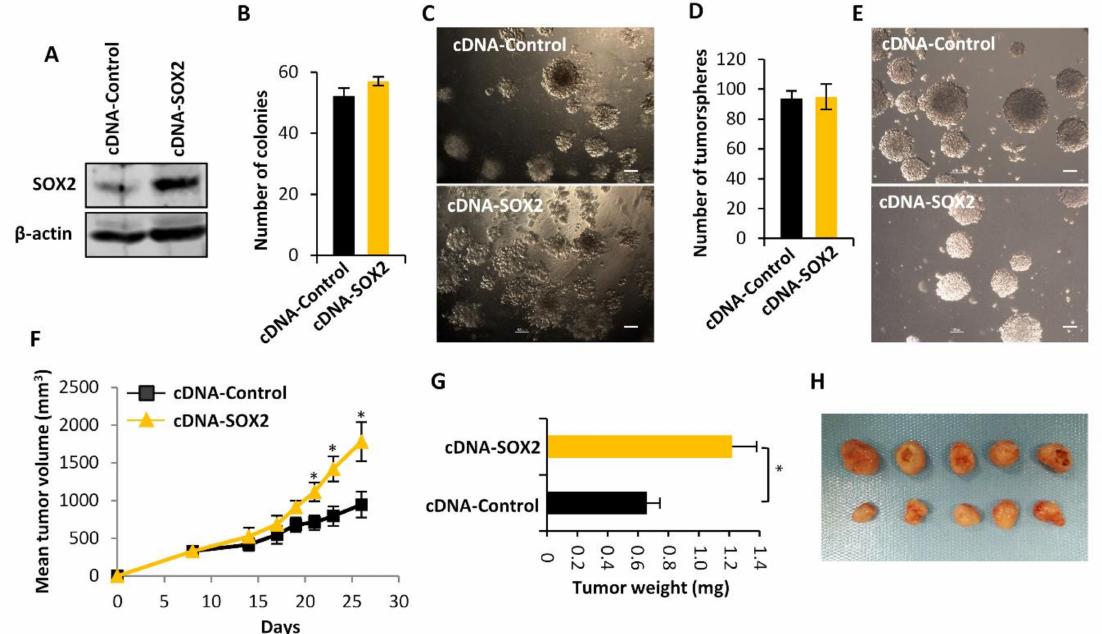
Figure 3. The overexpression of SOX2 increased the tumorigenic potential of sarcoma cells. T-5H-0 cells were stably transduced using lentiviral vector to express EGFP cDNA (cDNA Control) or human SOX2 cDNA (cDNA SOX2) sequences. ( A ) Western blotting analysis of SOX2 expression. ( B , C ) Quantification of the number of colonies formed ( n = 3 independent experiments) ( B ) and representative images of soft agar assays ( C ) performed with control and SOX2-overexpressing cells. ( D , E ) Average number of tumorspheres generated in three independent experiments ( D ) and representative images of the indicated tumorsphere cultures ( E ). Scale bars = 100 µ m. ( F – H ) Evaluation of tumor growth observed after the inoculation of 1 × 10 6 cells stably transfected with cDNA Control or cDNA SOX2 in immunode ffi cient mice. Tumor growth kinetics ( F ), tumor weights ( G ) and images of tumors at the end of the experiment ( H ) are presented. Error bars represent the standard deviation and asterisks indicate statistically significant di ff erences (*: p < 0.05 by two-sided Student t